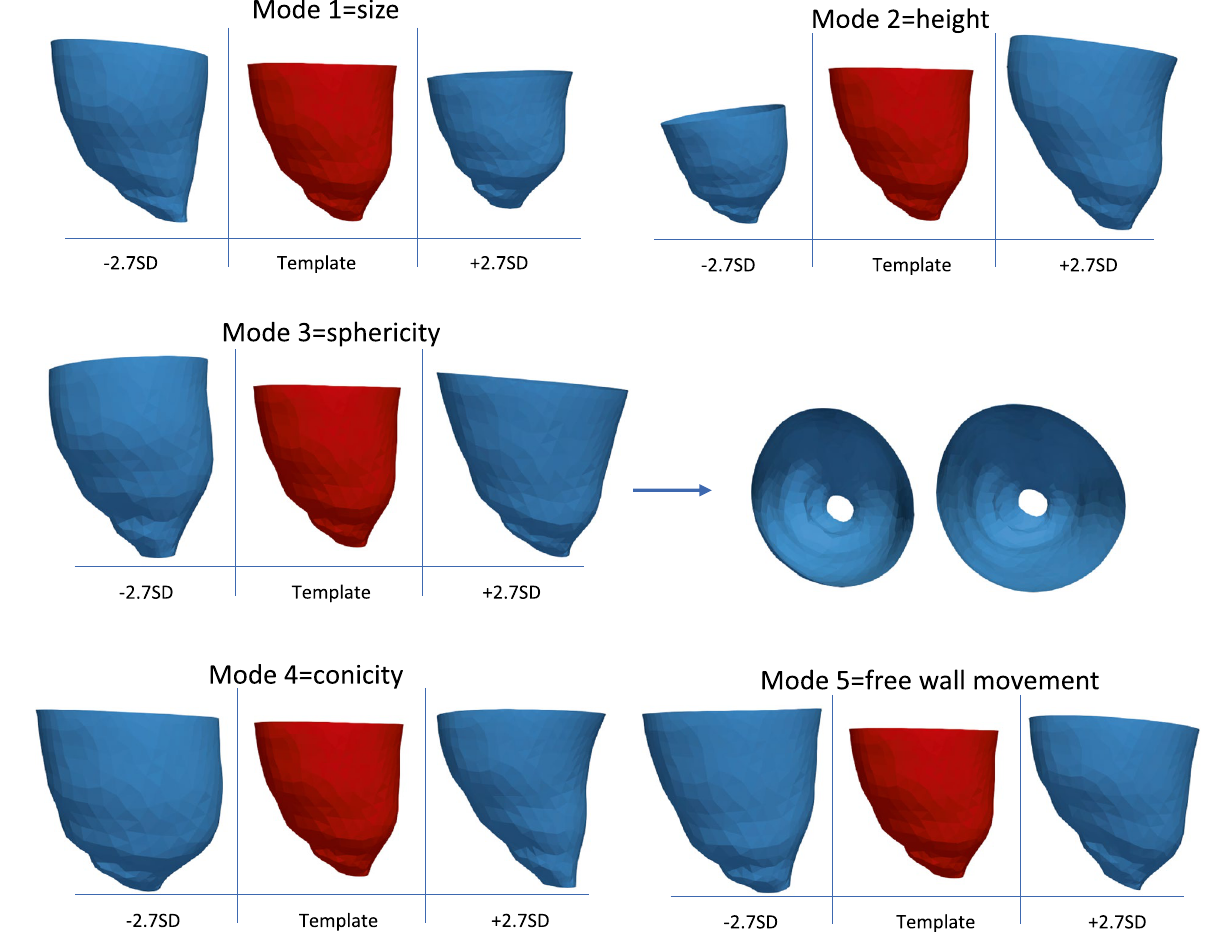
Figure 4. Shape modes. Illustration of the five computed shape modes capturing LV variation (± 2.7 SD from the mean configuration, representing the shape mode extremities, or more extreme anatomic features in this population). For each mode, it is indicated what the mode overall captures, e.g., Mode 1 = size. SD = standard deviation.